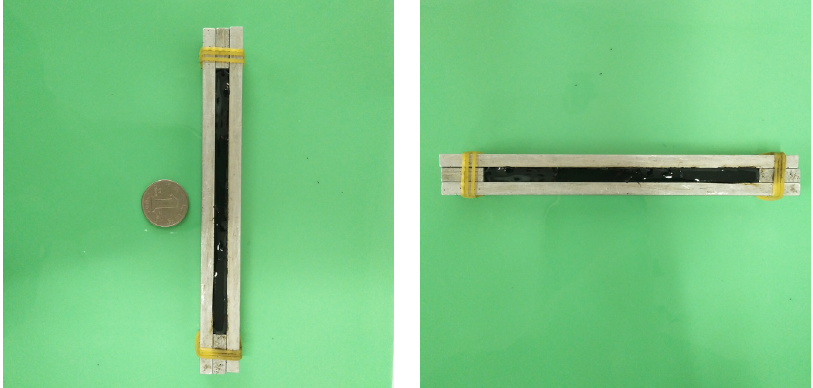
Figure 2. Specimen of the bending beam rheometer test.